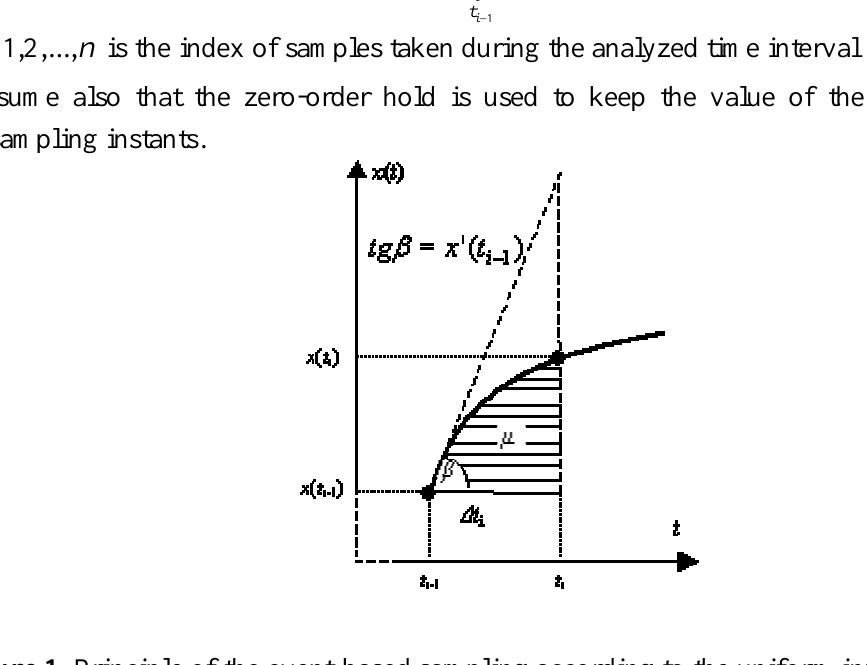
Figure 1 . Principle of the event-based sampling according to the uniform integral